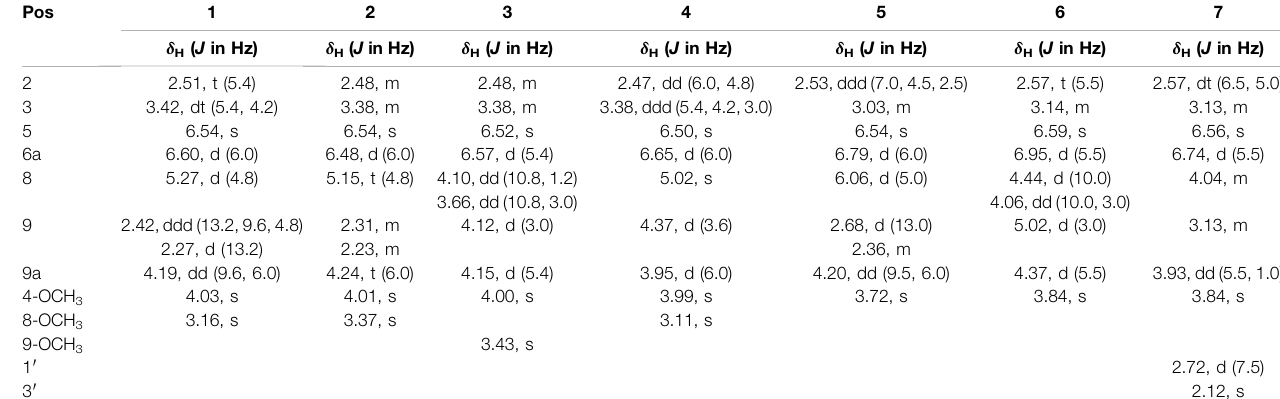
TABLE 2 | 1 H NMR data of compounds 1 - 4 in acetone- d 6 at 600 MHz and 5 - 7 in pyridine- d 5 at 500